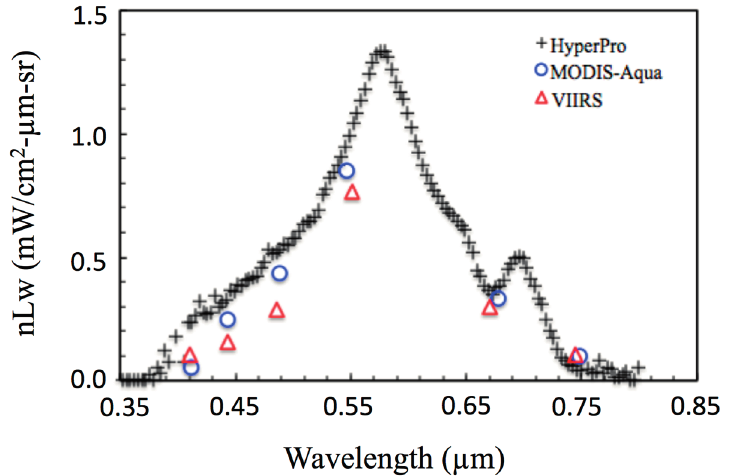
Figure 6. A comparison of normalized water-leaving radiances (nLw) retrieved on 10 January 2013 from VIIRS data, MODIS data, and a field-measured spectrum over a turbid water area in the Chesapeake